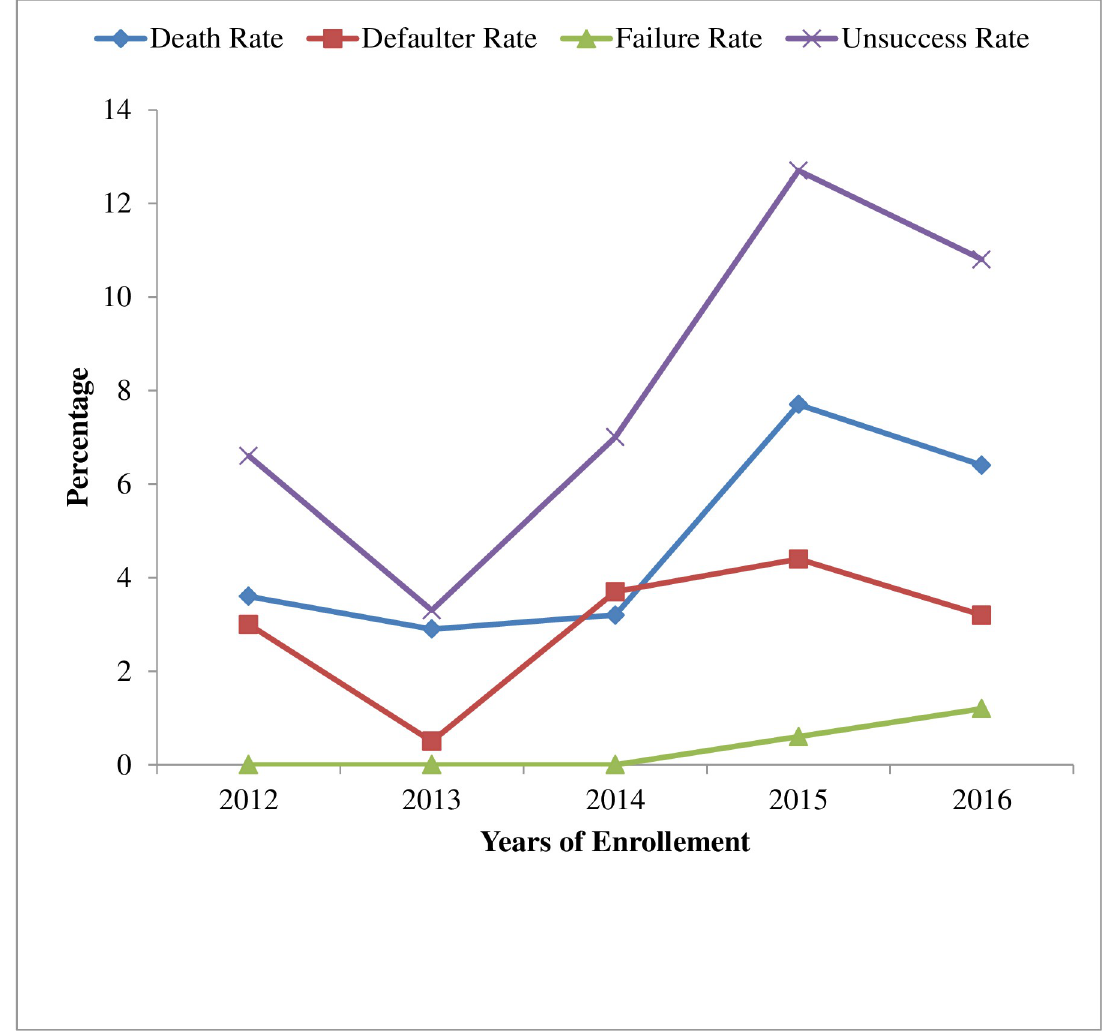
Fig 6. Trends of treatment unsuccessful rates of TB patients at three TB treatment centers in East Wollega from 2012 to